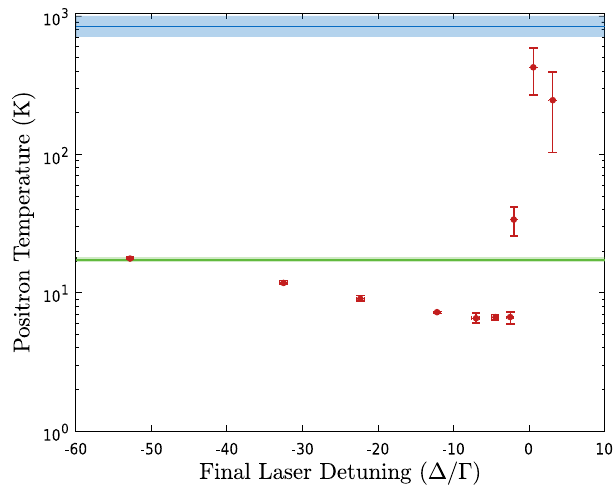
Fig. 2 Axial e + temperature in a mixed Be + /e + plasma as a function of the fi nal detuning ( Δ ) of the Be + cooling laser. The mixed plasma consisted of 2.6 × 10 6 e + , with an initial radius and density of 0.64 mm and 3 × 10 8 cm − 3 , respectively, and 3.8 ± 0.1 × 10 5 Be + ions. The laser frequency was swept from an initial detuning of − 104 Γ to the fi nal laser detuning in ~40 s. The error bars give the standard error of multiple measurements at each setting. The green line shows the e + temperature in the absence of any Be + ions (17.3 ± 0.5 K), and the blue line shows the e + temperature when the laser is blocked and the Be + ions are not laser- cooled. The shading around these lines indicates the standard